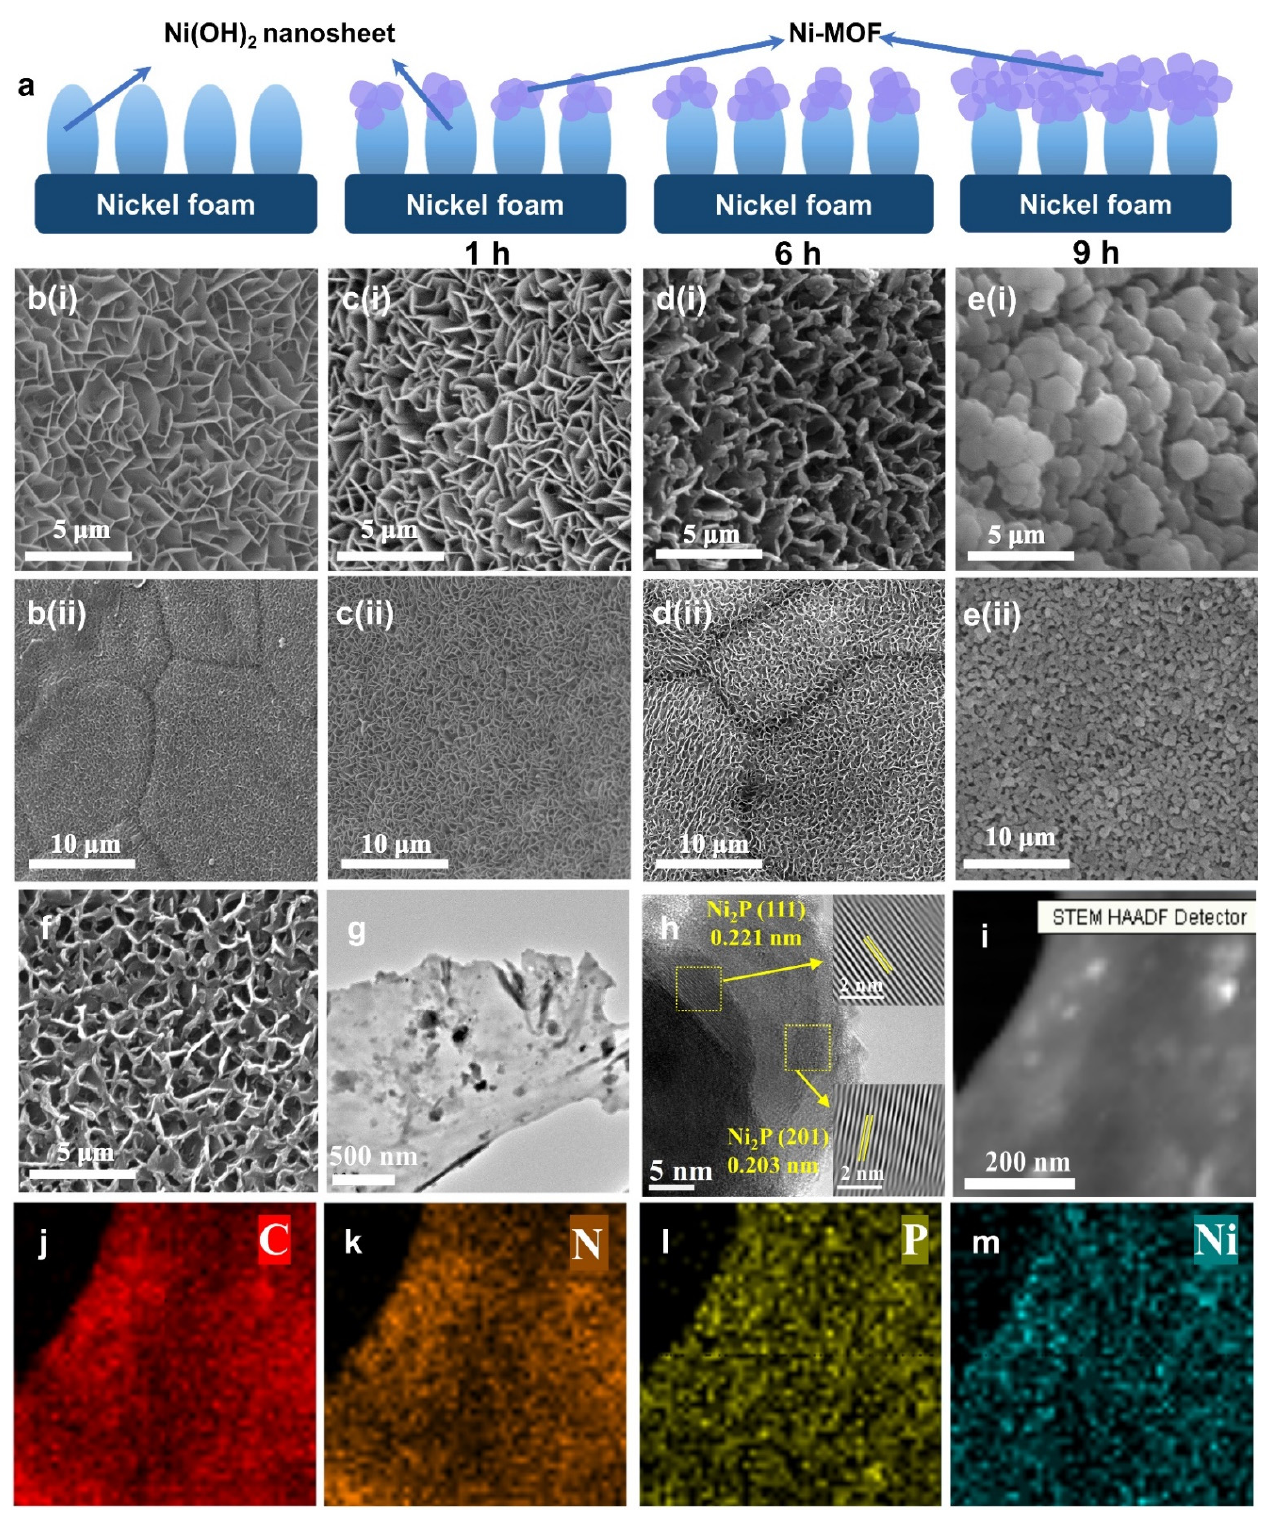
Figure 2. ( a ) Schematic diagram of in situ growth of Ni-MOF on Ni(OH) 2 nanosheets. SEM micro- scopic topography: ( b ) Ni(OH) 2 nanosheets, ( c ) growth time of Ni(OH) 2 /Ni-MOF/NF for 1 h and ( d ) growth time of Ni(OH) 2 /Ni-MOF/NF for 6 h. ( e ) Growth time of Ni(OH) 2 /Ni-MOF/NF for 9 h, and ( f ) Ni 2 P/NPC/NF with the reticular structure. The sample of Ni 2 P/NPC/NF: ( g ) TEM morphology, ( h ) HRTEM image and ( i – m ) EDX image of Ni 2 P/NPC/NF.